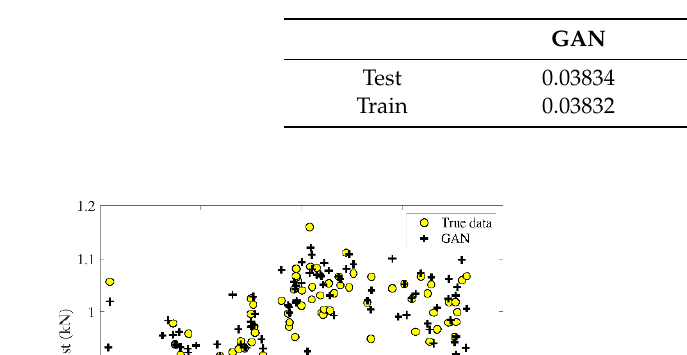
Table 4. RMSE for all methods.